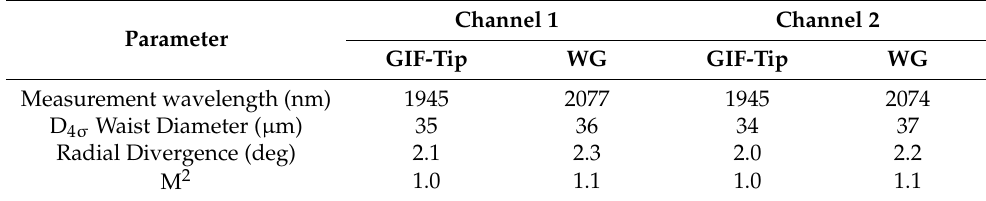
Table 2. GIF-tip and WG beam measurement and propagation fit results.